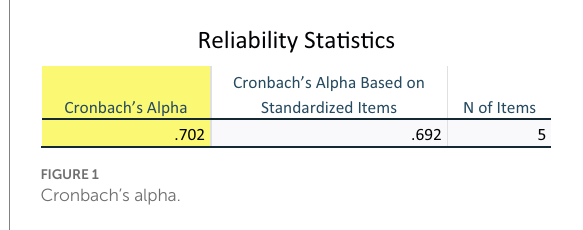
TABLE 4 Recommendations for